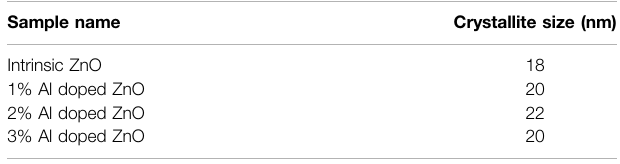
TABLE 1 | Average Crystallite size of